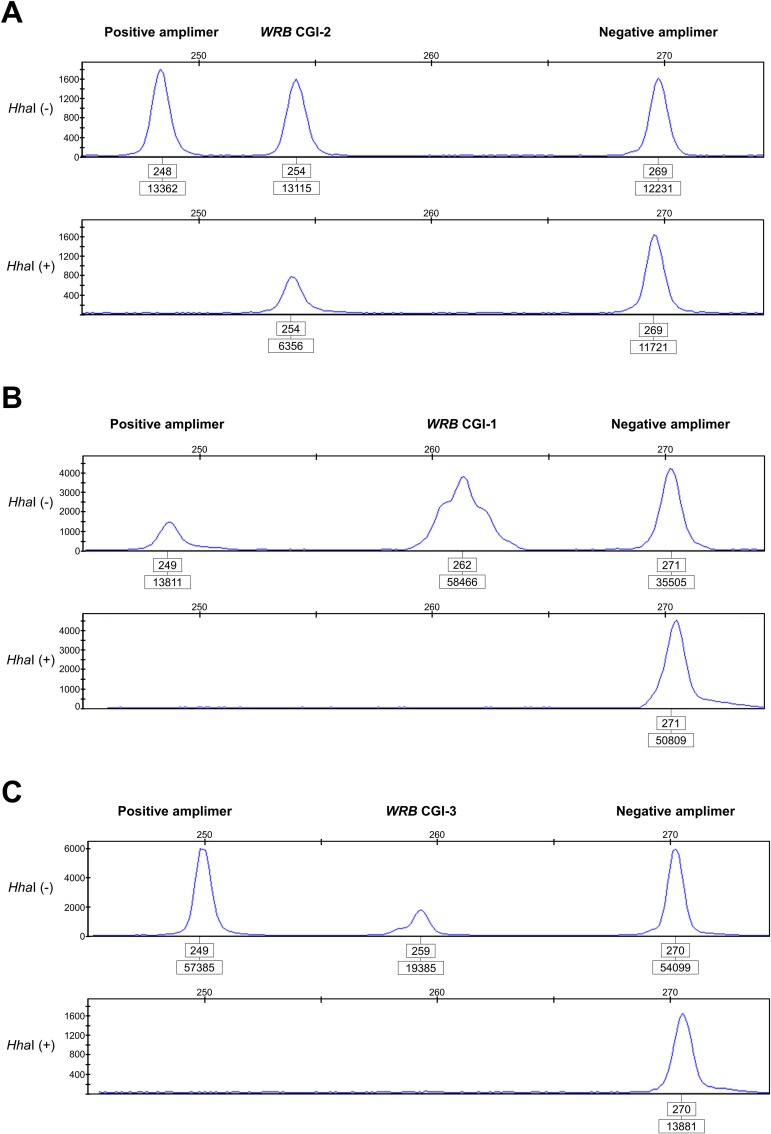
Experimental validation of the 5mCpG statuses at the WRB CGIs.(A) A consistent hemimethylated pattern at the WRB CGI-2 revealed in a representative control disomic DNA sample (blood) using the HhaI methylation-sensitive restriction enzyme-based PCR triplex assay developed in this study. Electropherograms of the amplimers generated from either undigested genomic DNA (upper panel) or DNA digested with HhaI (lower panel) genotyped via quantitative fluorescent PCR. The positive amplimer refers to a locus in the ESCO2 gene with constitutively hypomethylated CpG dinucleotides at the target restriction enzyme sites (100% susceptible to HhaI digestion). The negative amplimer refers to a WRB region that lacks HhaI sites, and is, therefore, refractory to enzymatic digestion. The numbers in the upper boxes correspond to the amplimer lengths in base pairs while those in the lower boxes refer to the areas under the peak of the amplimer. In this representative DNA sample, the ratio of 5mCpG sites at the WRB CGI-2 was 50.6%. In contrast, the assay revealed a consistent unmethylated pattern of CpG sites at the WRB CGI-1 (B) and WRB CGI-3 (C).